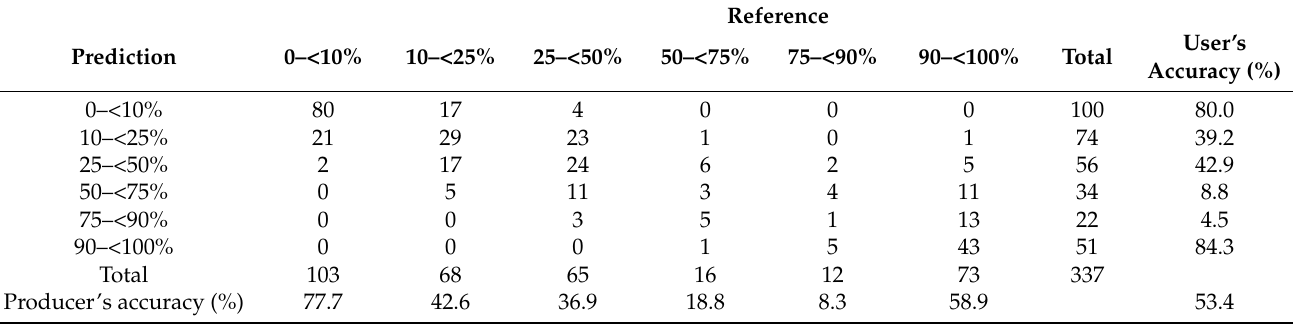
Table A19. Confusion matrix for Southwest model predicting EA scorch-adjusted canopy cover change with Sentinel-2 RBR with